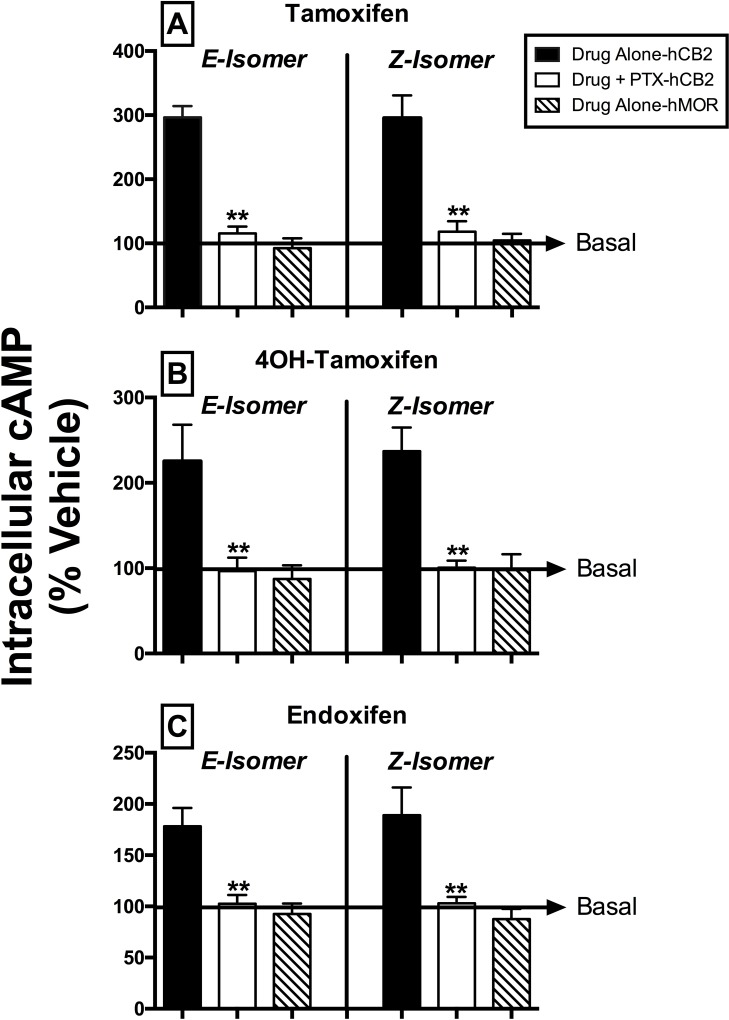
SERM isomers modulate forskolin-stimulated AC activation via Gi/o proteins and CB2Rs.[A-C] Modulation of forskolin-stimulated cAMP production by SERMs (10 μM) in intact CHO-hCB2 and CHO-hMOR cells was evaluated. Drugs were examined in CHO-hCB2 cells (+/- 100 ng PTX pretreatment) and in CHO-hMOR cells not expressing CBRs. Intracellular cAMP values (mean ± SEM) are presented as percent response compared to levels observed in the presence of vehicle. Statistics revealed that no drug altered basal cAMP levels in CHO-hCB2 cells treated with PTX (P<0.01; student’s t-test) or in CHO-hMOR cells (P<0.01; one-sample t-test).